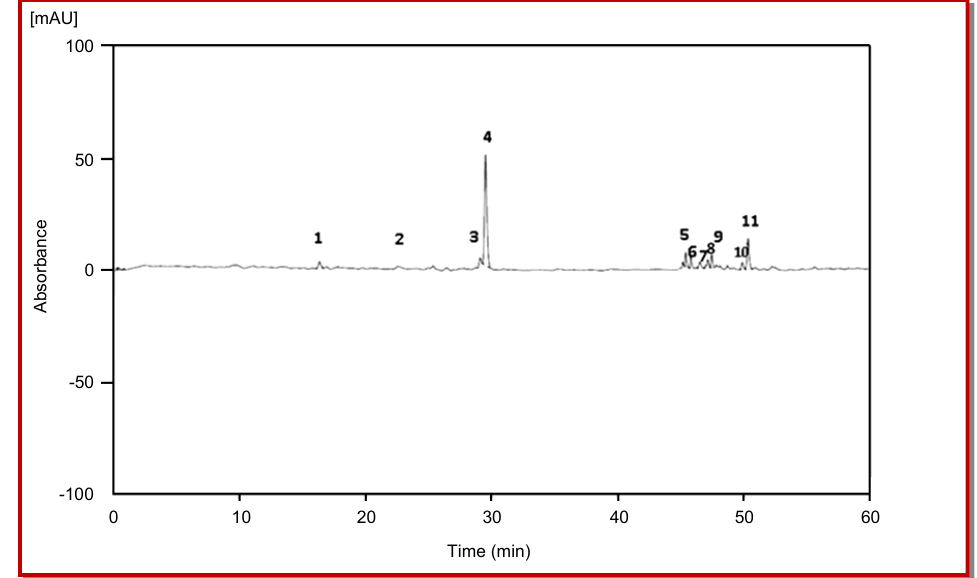
Figure 3. HPLC chromatogram of at 280 overlaid. Peaks: 1, caffeic acid; 2,p-coumaric acid; 3, Rutin; 4, rosmarinic acid; 5,Quercetin;